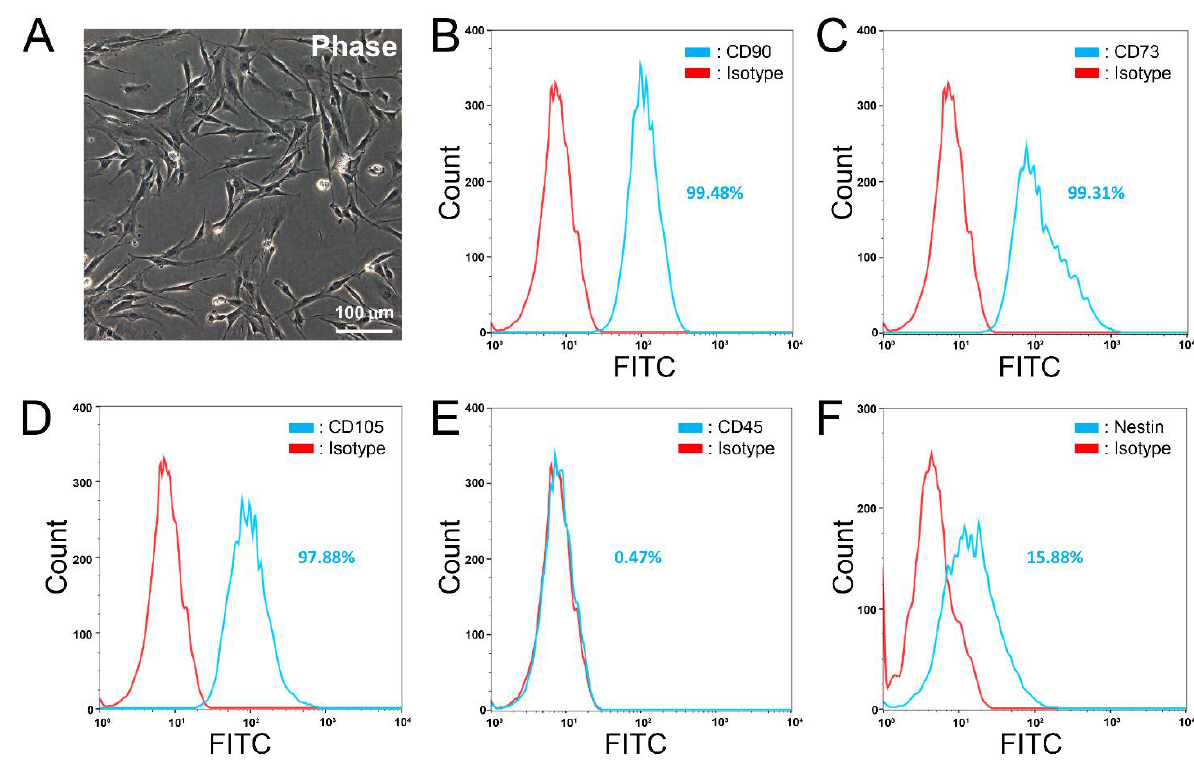
Figure 1. Flow cytometric analysis of aMSCs in culture. ( A ) Phase contrast micrograph showing fibroblastic morphology typical of aMSCs in passages 3–5. ( B – D ) Representative histograms showing high expression of mesenchymal stem cell markers CD90 ( B , 99.48%), CD73 ( C , 99.31%) and CD105 ( D , 97.88%). Hematopoietic marker CD45 ( E ) was only positive in 0.47% of cells. The neural progenitor marker nestin was positive in 15.88% of cells ( F ). n = 4 independent preparations of aMSCs.